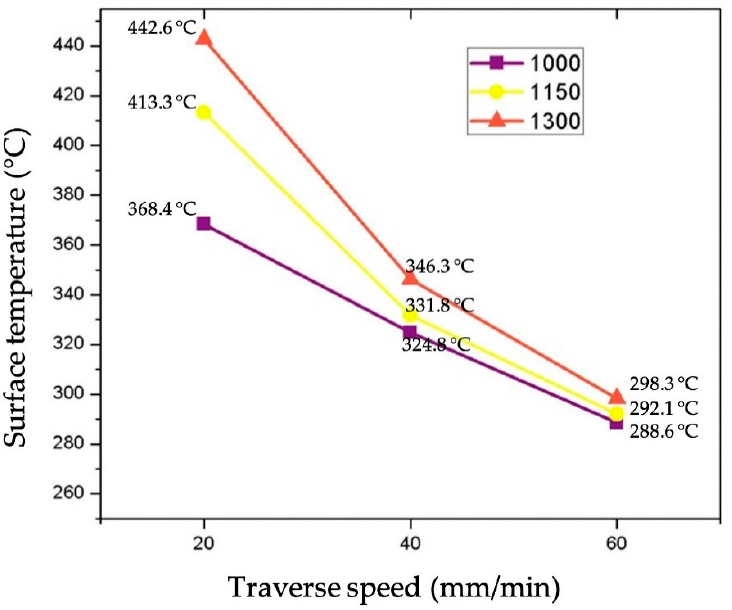
Figure 5. Maximum surface temperature profiles of different condition of welding.